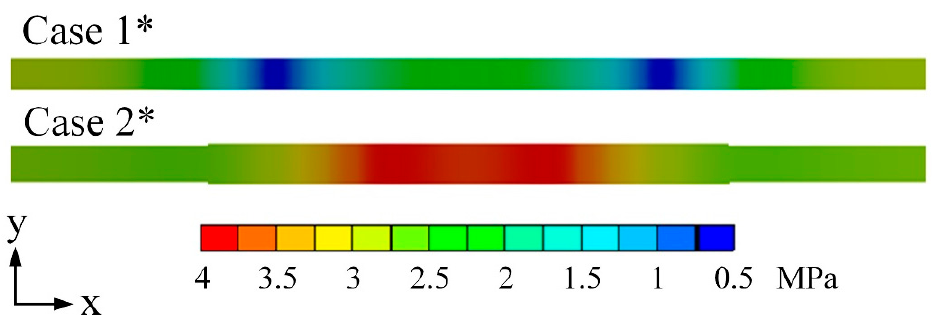
Figure 5. Equivalent stress distribution of the membrane in Case 1* and Case 2*.